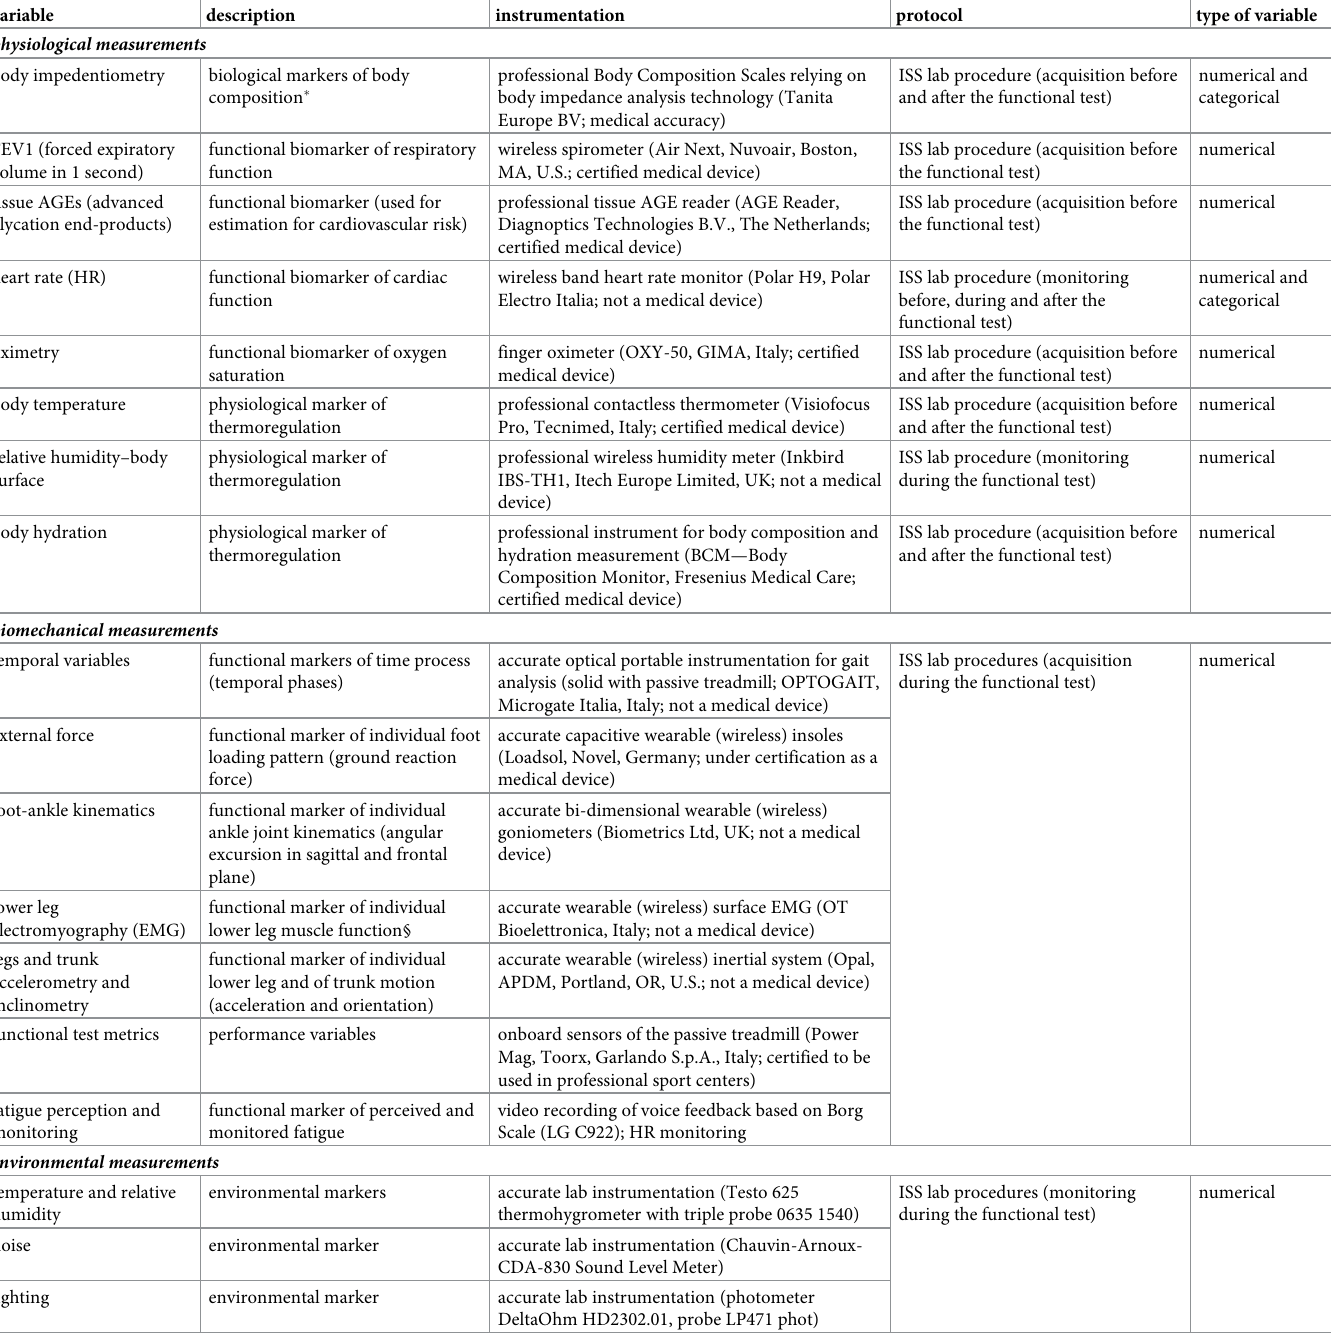
Table 2. Biomechanical, physiological and environmental